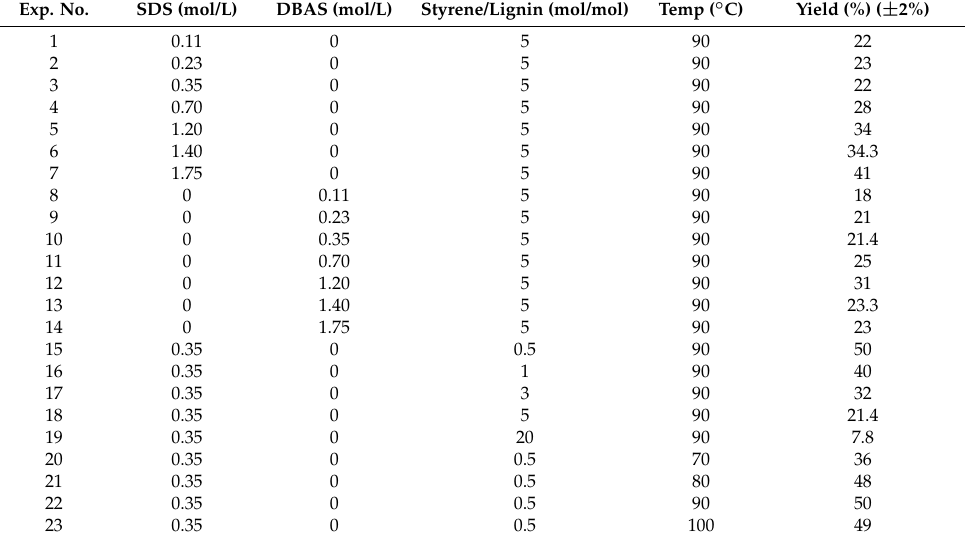
Table 1. Formulation of lignin and styrene emulsion polymerization and corresponding yields (%) of the